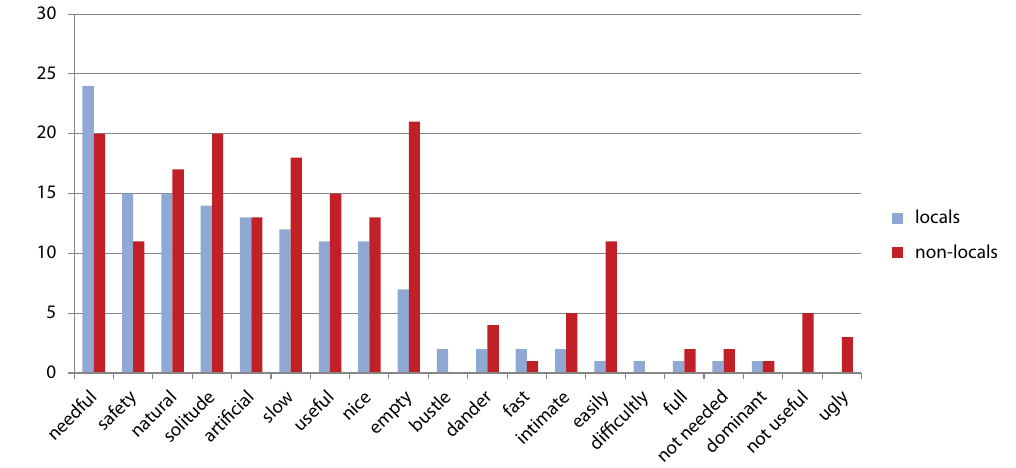
fig. 4. attributes of the Central Park according to its